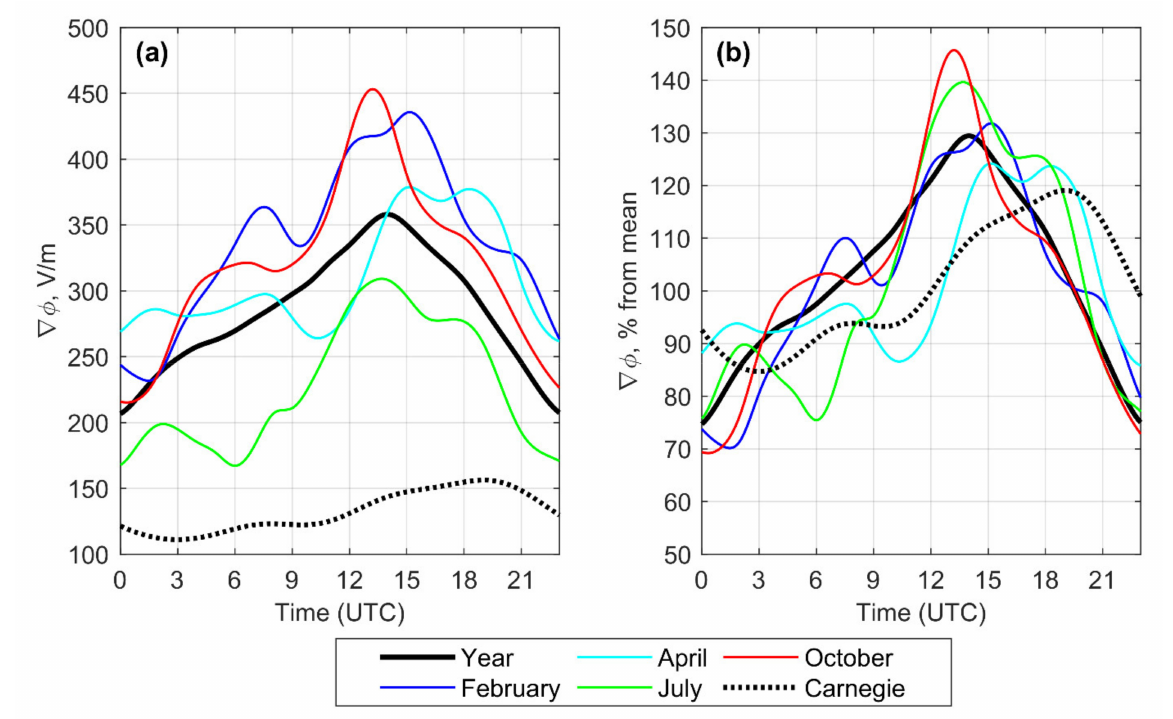
Figure 7. Smoothed daily variations in absolute ( a ) and normalized ( b ) potential gradient under fair-weather conditions (February, April, July, and October and the annual average values calculated for 2006–2020) obtained at Tomsk in comparison with the unitary variation (Carnegie curve [1]). The diurnal variations in the normalized versus average ∇ ϕ values in Tomsk are generally consistent with the unitary variation. Hourly means of the potential gradient with month of the year in the south of Western Siberia are generally characterized by a minimum in the morning (00 UTC) during summer and a maximum in the evening (14 UTC) during late winter (see Figure 8). However, their primary minimum and maximum are 03 and 05 UTC earlier than a similar one on the Carnegie curve, respectively (see Figure 7b).